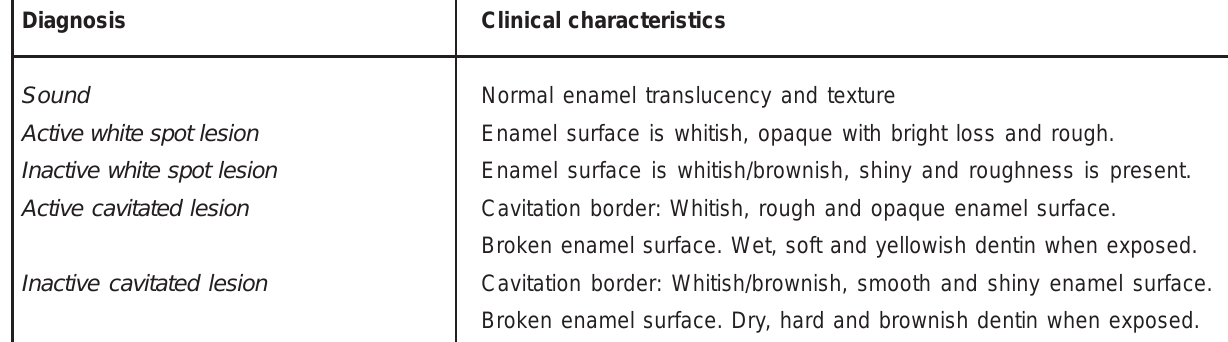
FIGURE 1- Clinical criteria for visual inspection